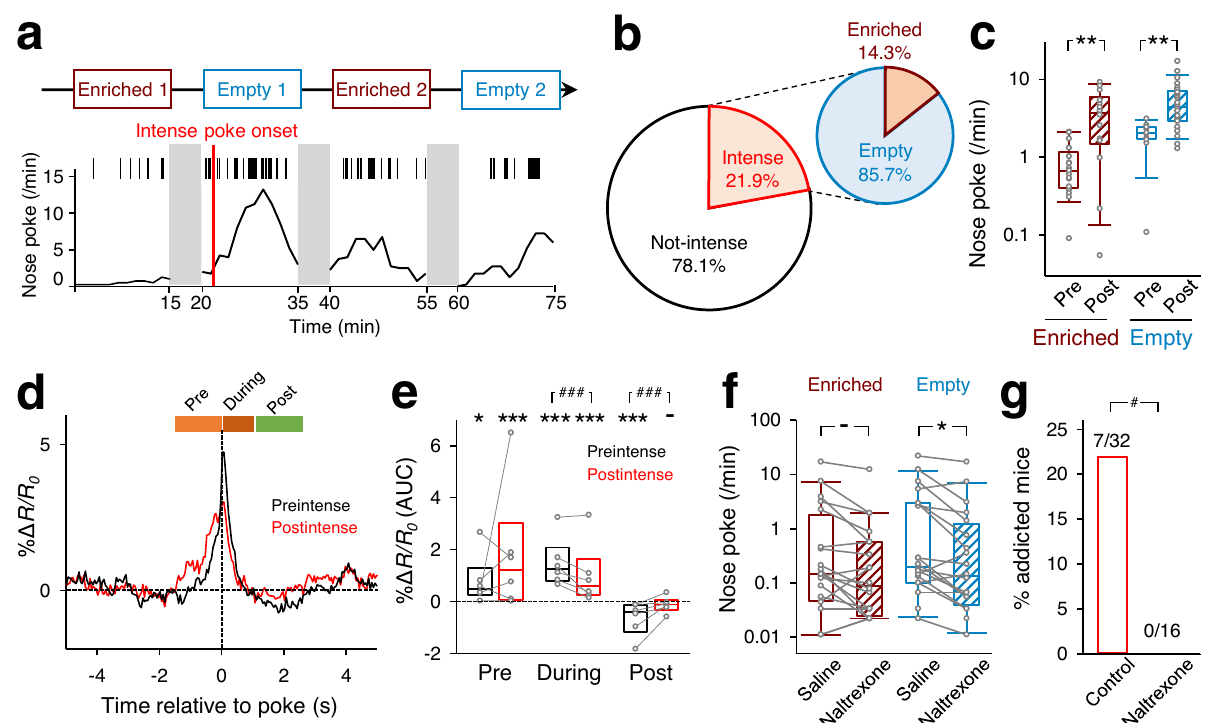
Fig.4|Pharmacologicalblockadeofopioidreceptorspreventsintenseair-puff seekingtonosepokes.a Datafromarepresentativemousethatexhibitedintense nose-poking behavior. The red line indicates the onset of intense behavior (threshold: 2.4 pokes/min). b The left graph indicates the percentage of mice that exhibitedintensebehavioralstates,andtherightgraphindicatesthepercentageof thesessiontypesinwhichmiceexhibitedintensebehavioralstatesforthe fi rsttime (right). n =32 mice. c Frequencies of nose pokes in enriched (dark red) and empty (blue) chambers before (pre) and after (post) the onset of an intense behavioral state. The box plots indicate the median, interquartile range, and extreme values. ** P =0.0020, 0.0044 for the enriched and empty condition, respectively., n Enriched_preintense =21 sessions, n Enriched_postintense =25 sessions, n Empty_preintense =11 sessions, n Empty_postintense =40 sessions, two-sided two-sample